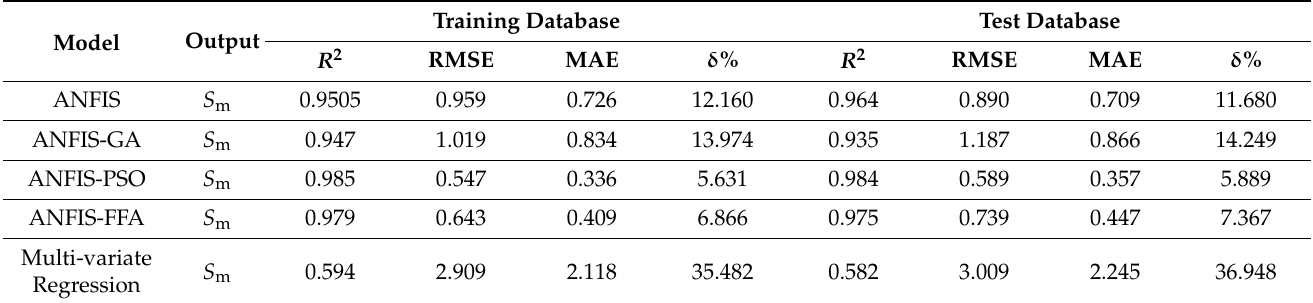
Table 2. Models’ performance evaluation for S m